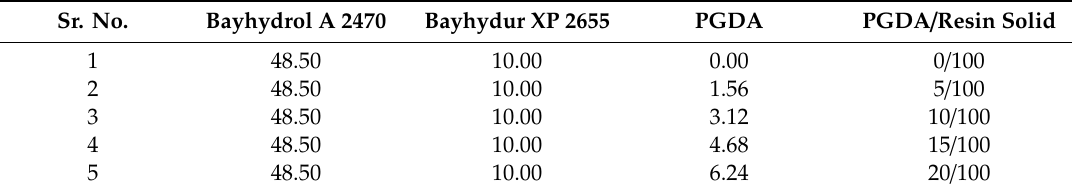
Table 4. Ratio of reactants for the curing process.